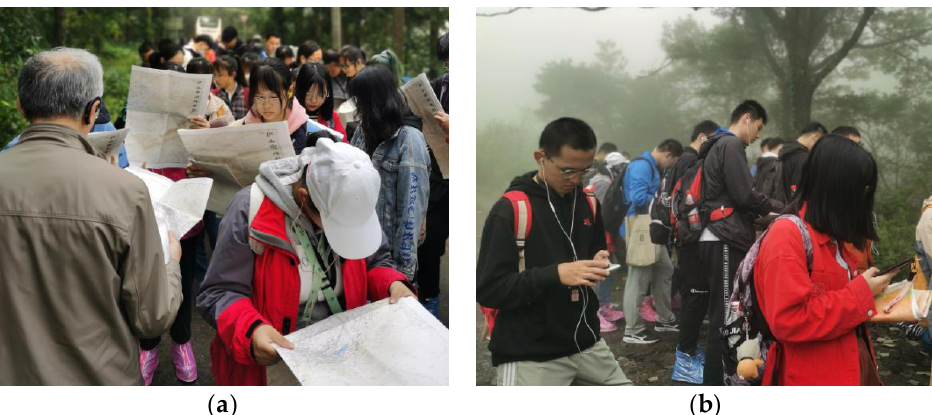
Figure 9. ( a ) Students read paper fieldwork maps. ( b ) Students browse the electronic map on the fieldwork platform.